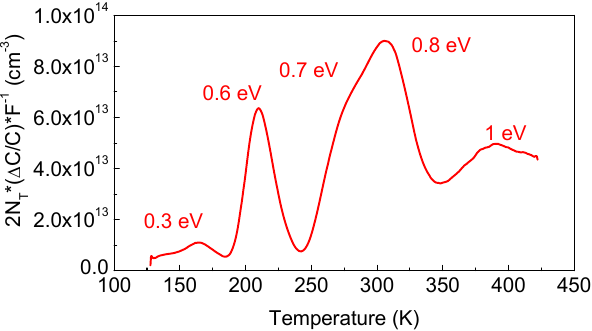
Figure 11. DLTS spectrum with pulsing from − 1 V to 2 V, time windows 1.5 s/15 s.